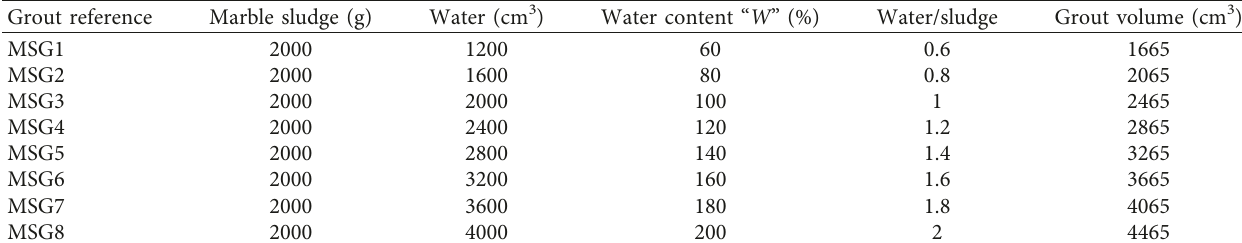
Table 5: Composition of